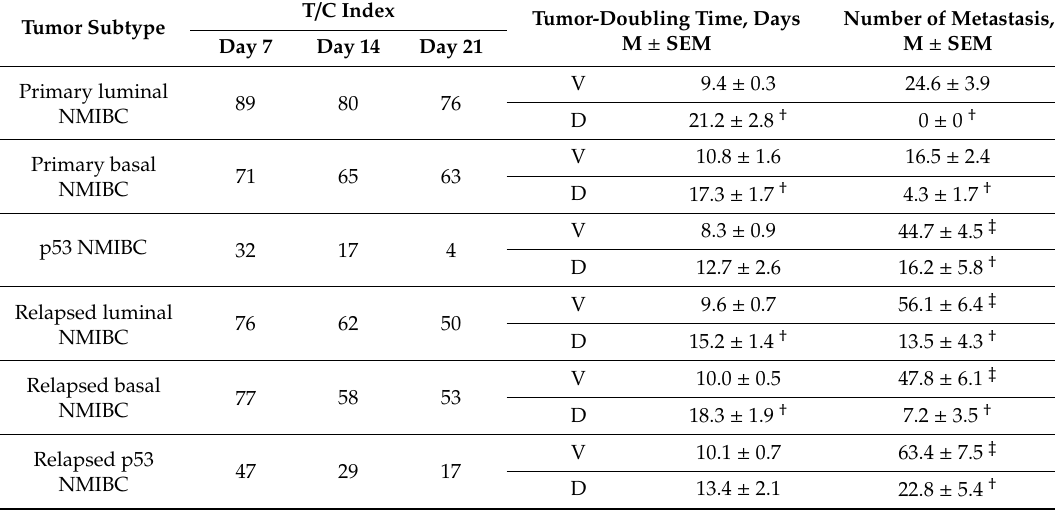
Table 2. Treatment inhibits bladder cancer PDXs growth and lung metastasis (initially n = 10 in each subgroup).